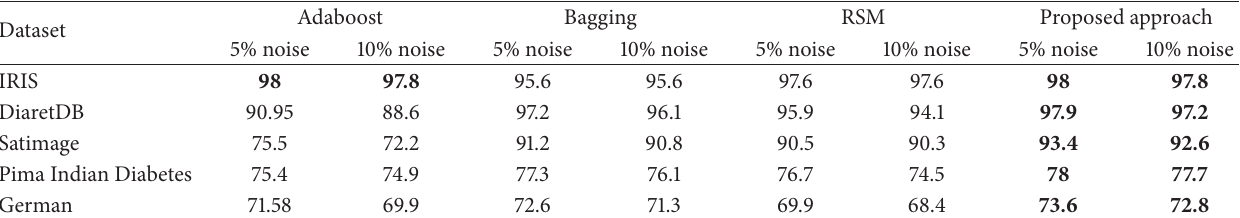
Table 6: Comparison based on classification accuracies of proposed approach as compared to competitors in the presence of different levels of class label